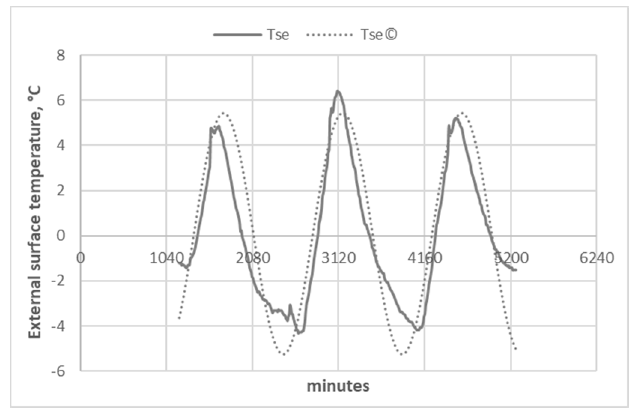
Figure 21. Casa Cembo straw wall: external surface temperatures (measured data indicated with the continuous line and calculated data with the dotted line).